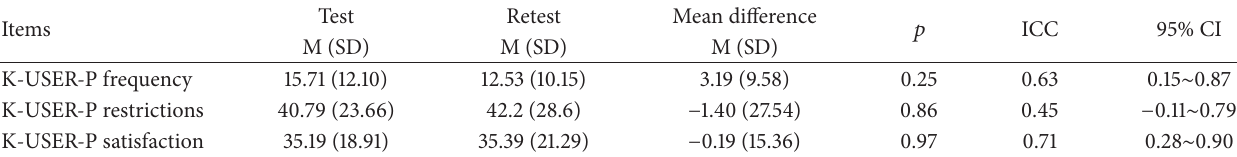
Table 3: Test-retest reliability ( 𝑁 = 13 ).